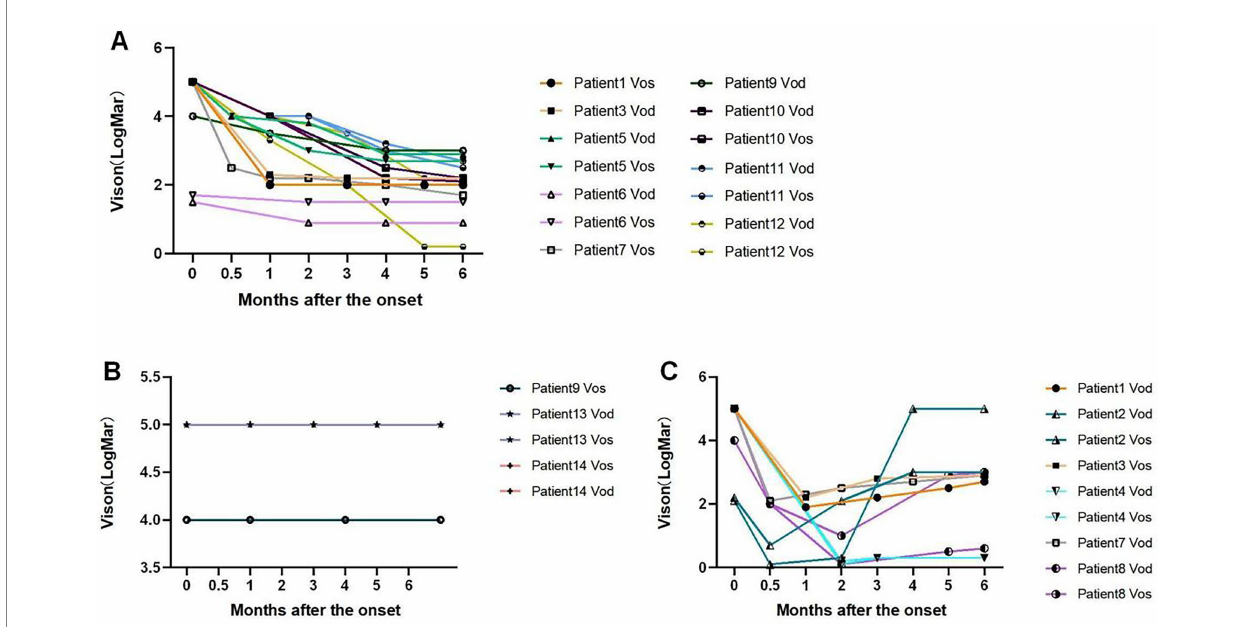
FIGURE 1 The developing trend of BCVA (logMAR) throughout the patient’s follow-up for 6 months. (A) The VA of nine patients (14 eyes) gradually increased after impairment and then remained stable. (B) Three patients (5 eyes) had no change in VA after impairment. Patient 9 Vos was in the line of Vision 4.0, Patient 13 Vod, Patient 13 Vos, Patient 14 Vod, and Patient 14 Vos were in the line of Vision 5.0. (C) Six patients (9 eyes) had a secondary decrease in VA early after impairment. However, VA turned down after 0.5 to 2 months. Vod, VA of oculus dexter; Vos, VA of oculus